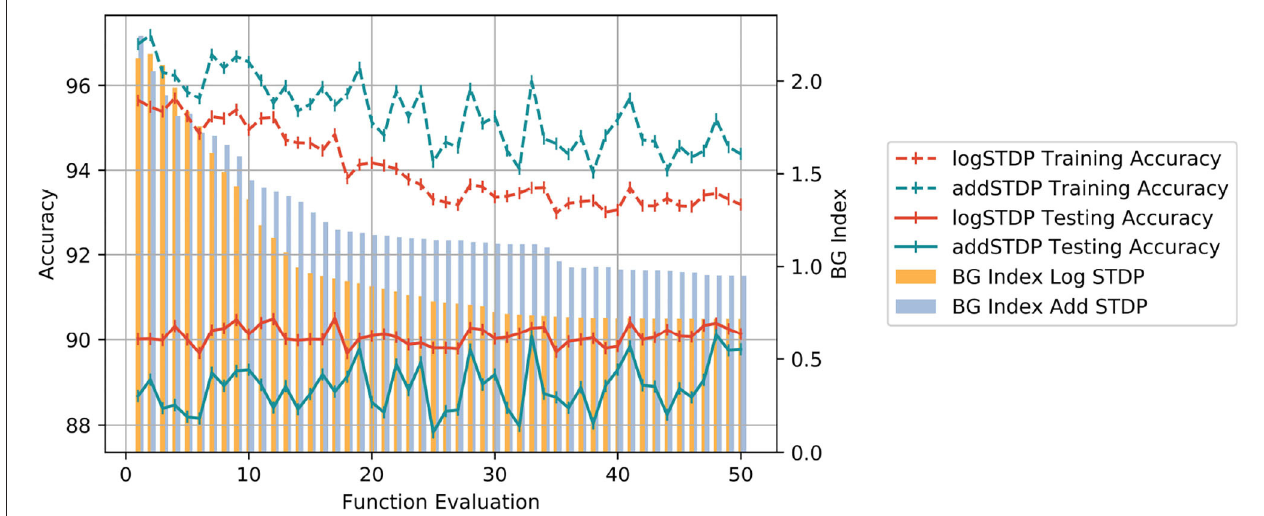
FIGURE 10 | Plot showing the change of BG Index, Training and Testing Accuracy between the add-STDP and log-STDP over functional evaluations during Bayesian Optimization.